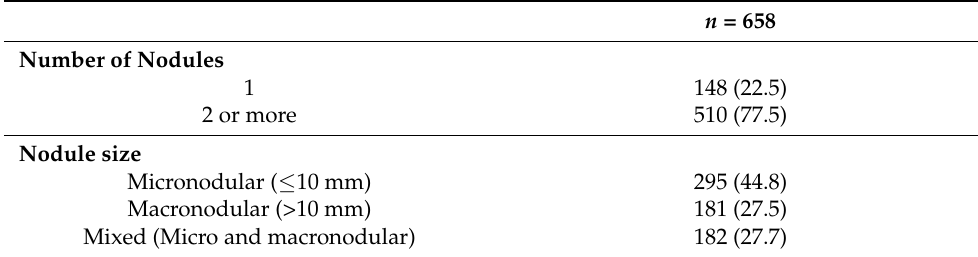
Table 3. Ultrasound characteristics of thyroid nodules.